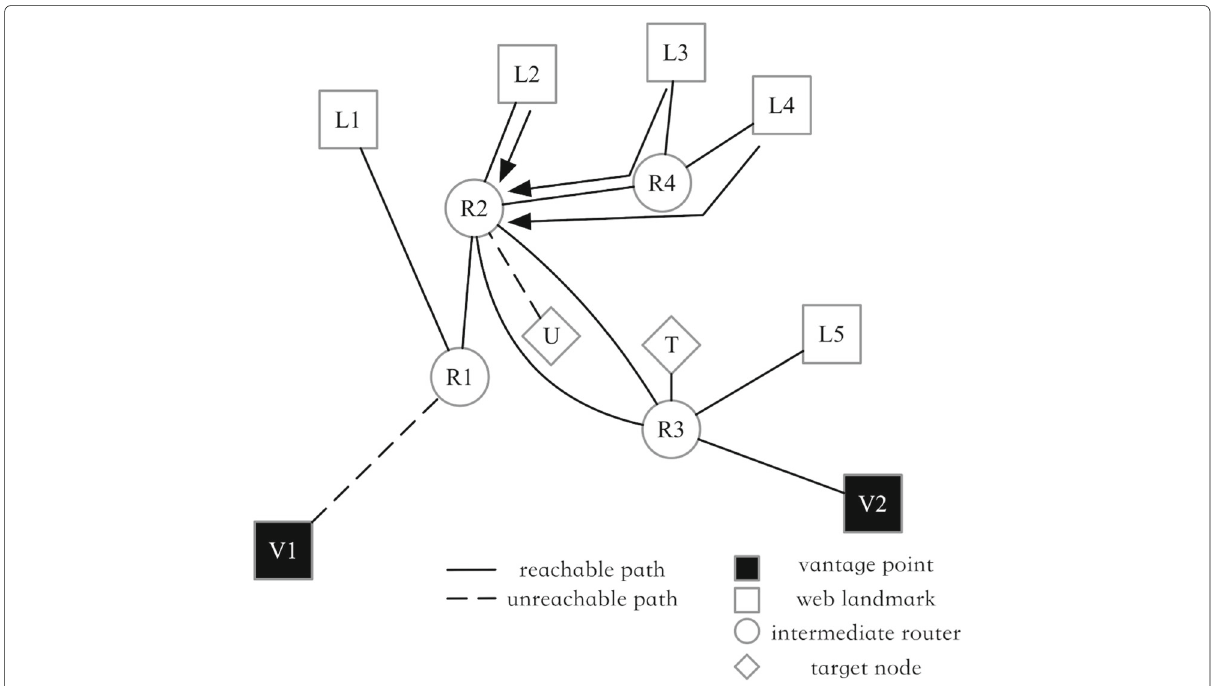
Fig. 5 Geolocate target host based on intermediate